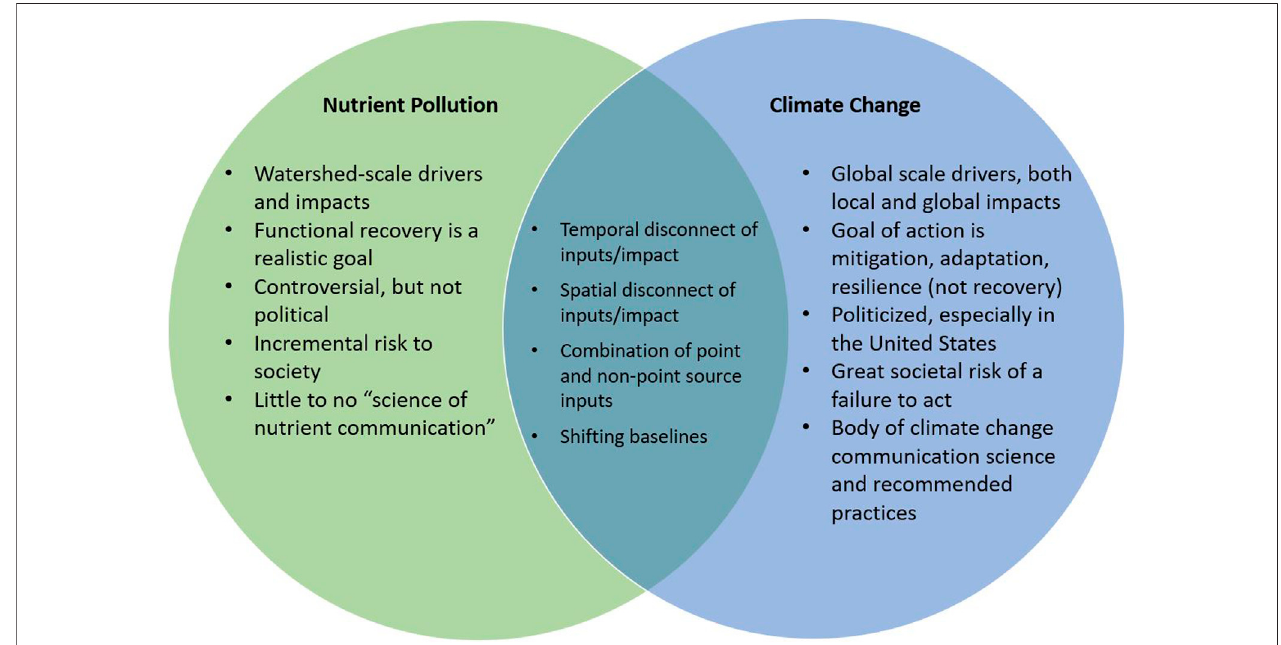
FIGURE 1 | Venn Diagram of similarities and differences between environmental issues of nutrient pollution and climate